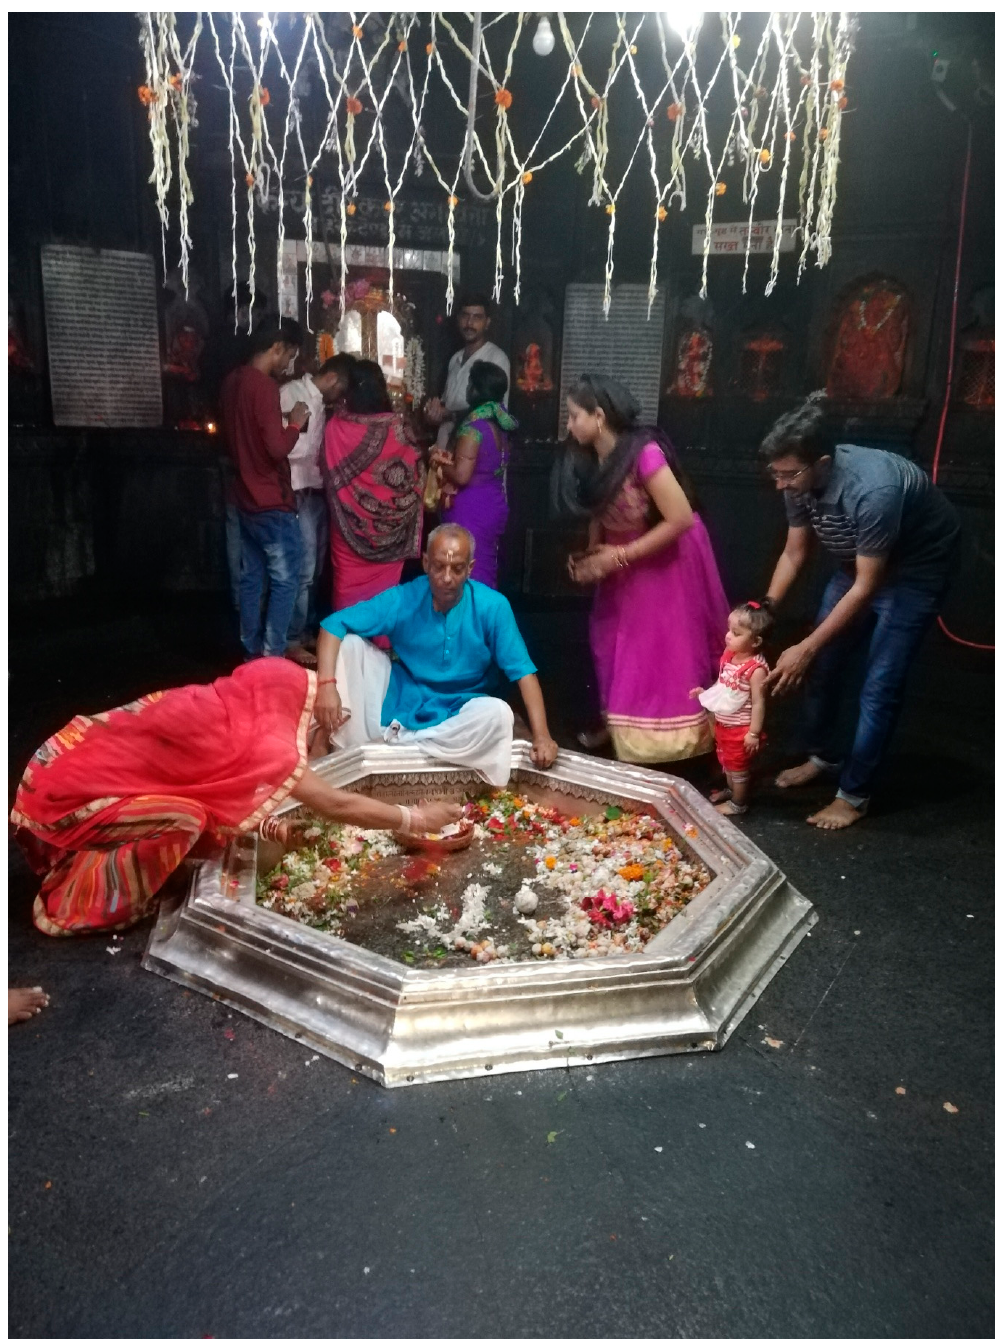
Figure 3. Gay ā —rituals around the footprint (picture made by Martijn Stoutjesdijk and Deborah de Koning, 10 July 2018).